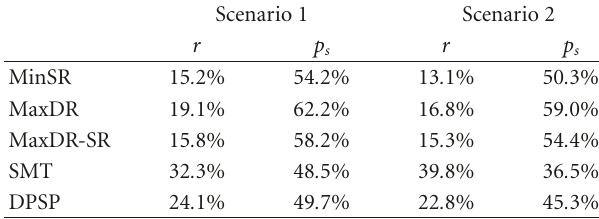
Table 2: Simulation results: single-attacker